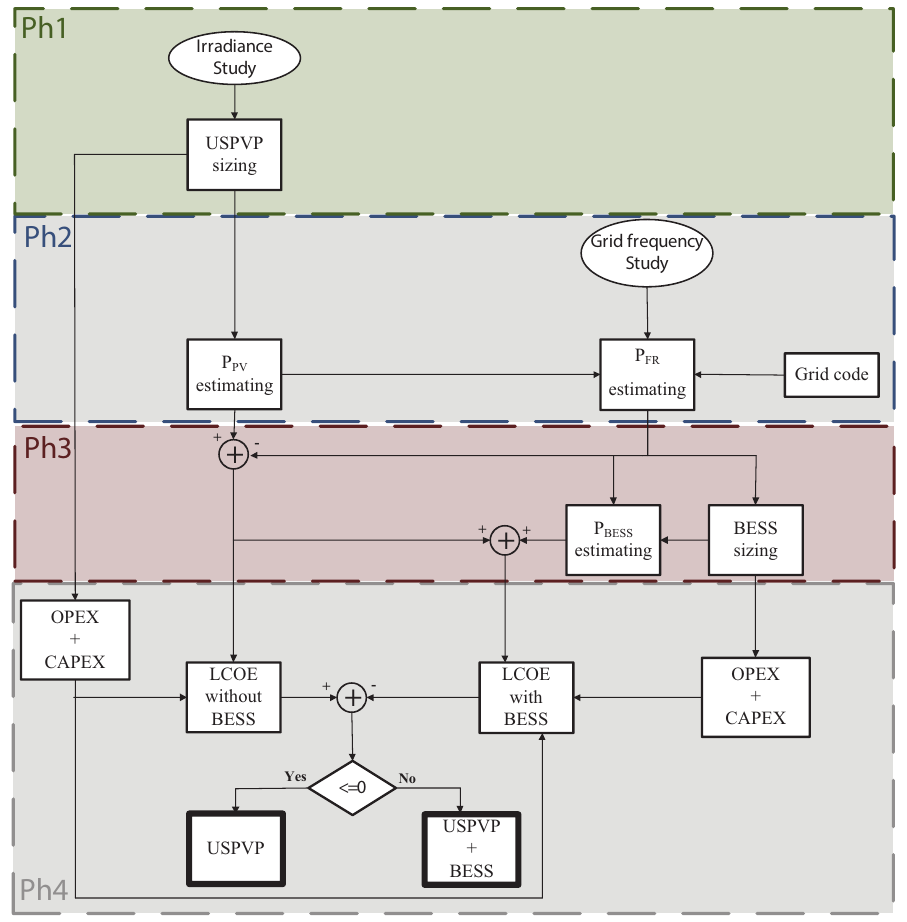
Figure 22. Summarised procedure to evaluate BESS whether new USPVPs can have economically viable BESS or not. Four phases are clearly distinguished: Phase 1: USPVP sizing; Phase 2: solar production generation and FR losses estimation; Phase 3: BESS sizing and total power production estimation; and Phase 4: LCOE calculation and